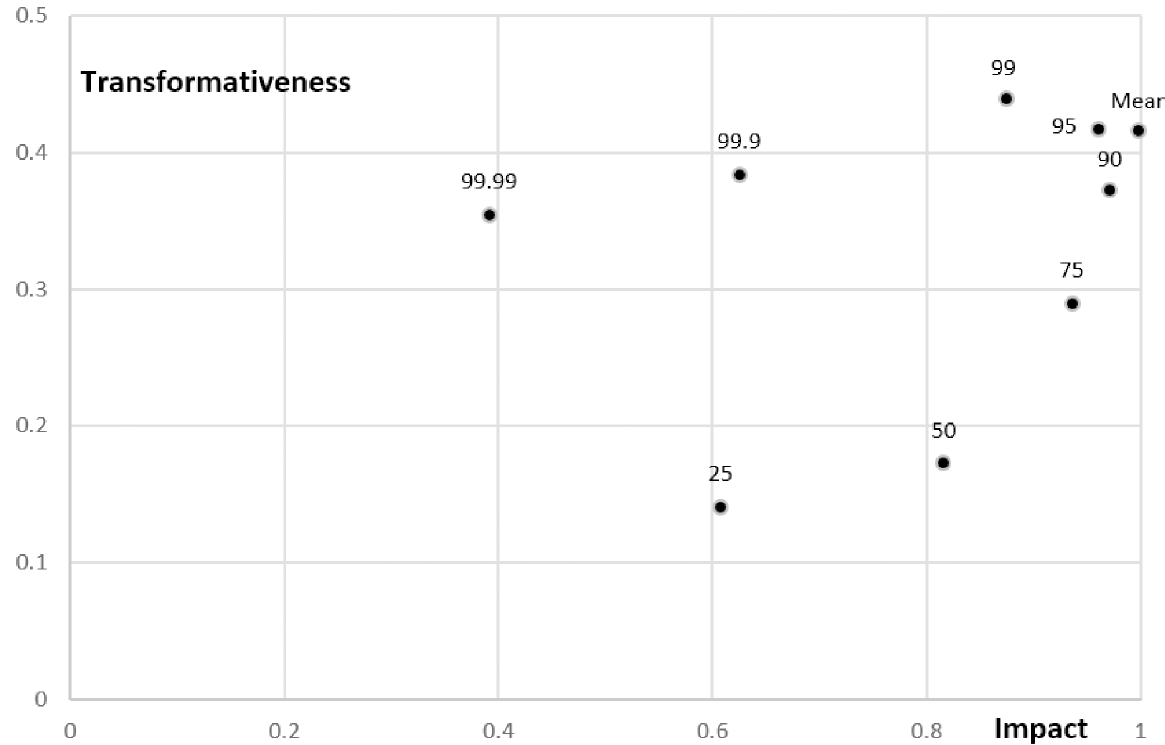
Fig 5. FCiteN related to impact and transformativeness. The figure shows the partial correlation between the individual metrics for impact and the overall metrics for transformativeness and impact across field-period pairs after eliminating variation across field and time (that is, time and field fixed